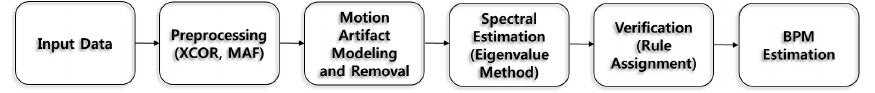
Figure 1. Functional block diagram of the heartbeat rate